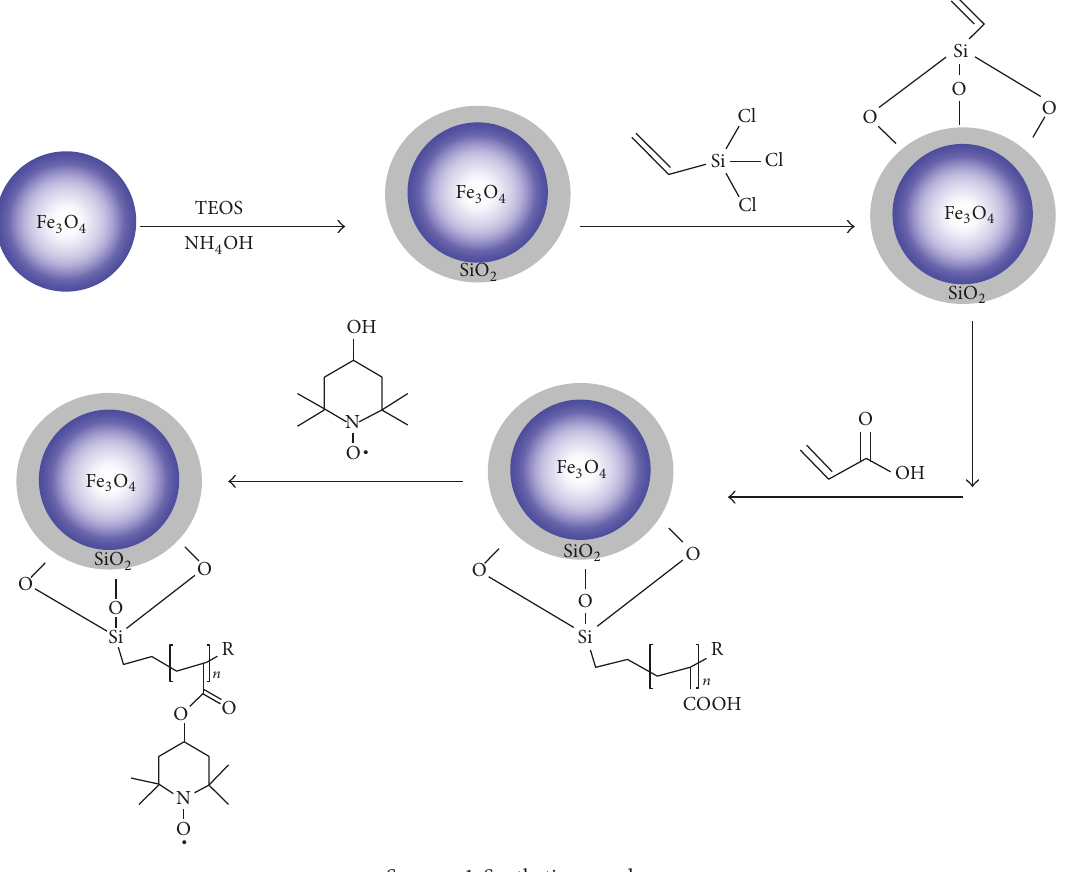
Scheme 1: Synthetic